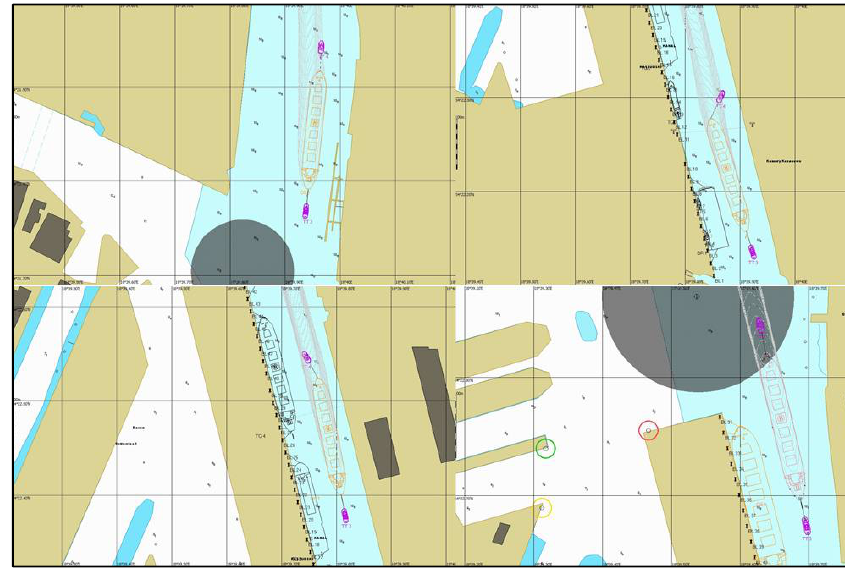
Figure 19. Simulation of a vessel towing in the Kashubian Canal.